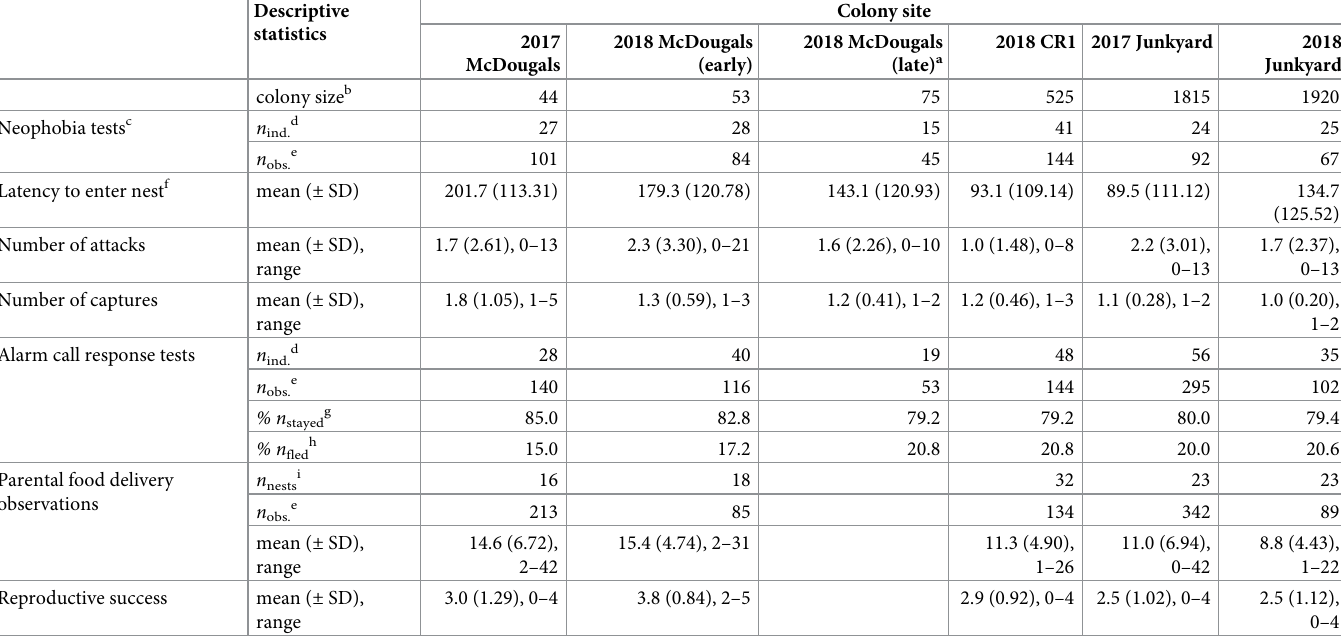
Table 1. Observation effort and mean values for cliff swallow behavioral tests, parental food deliveries, and annual reproductive success at six colonies over two